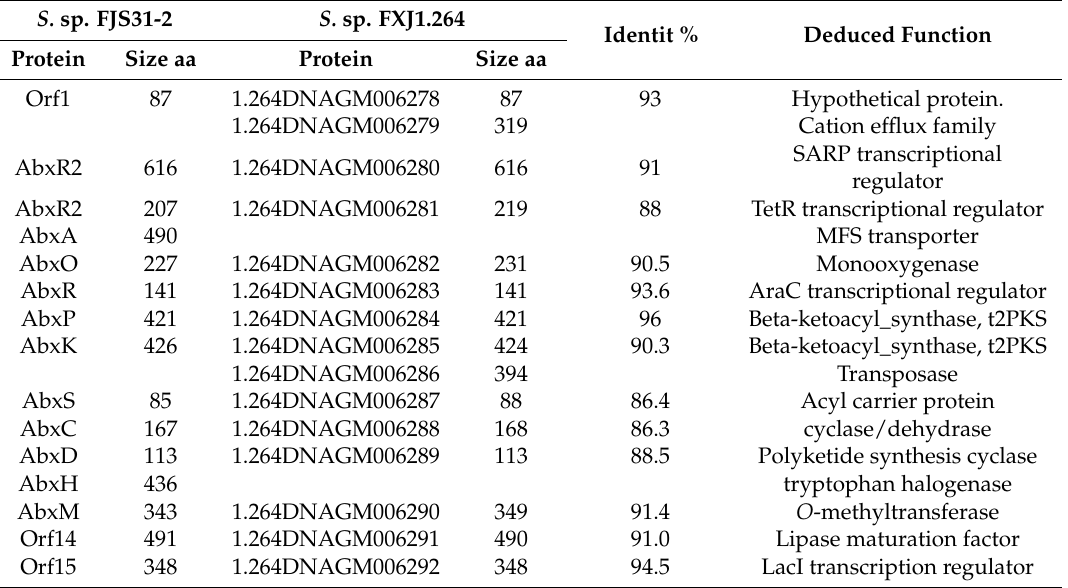
Table 1. Homologous analysis of abx gene cluster from Streptomyces